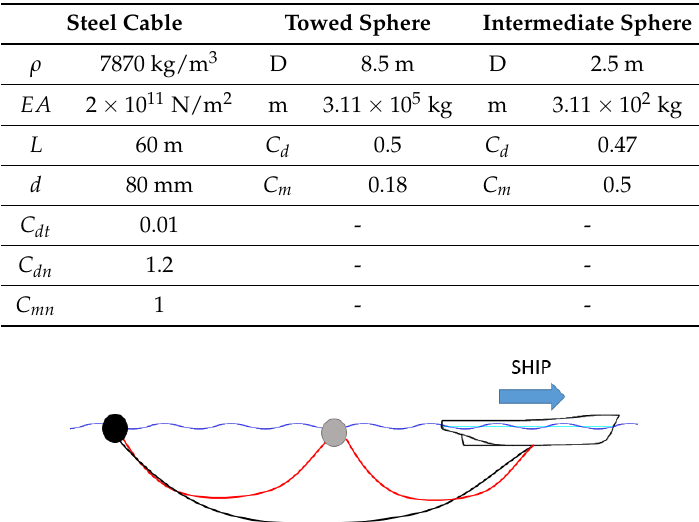
Figure 22. Setup of floating body towing system. Simple towing (black line), towing with intermediate body (red lines).